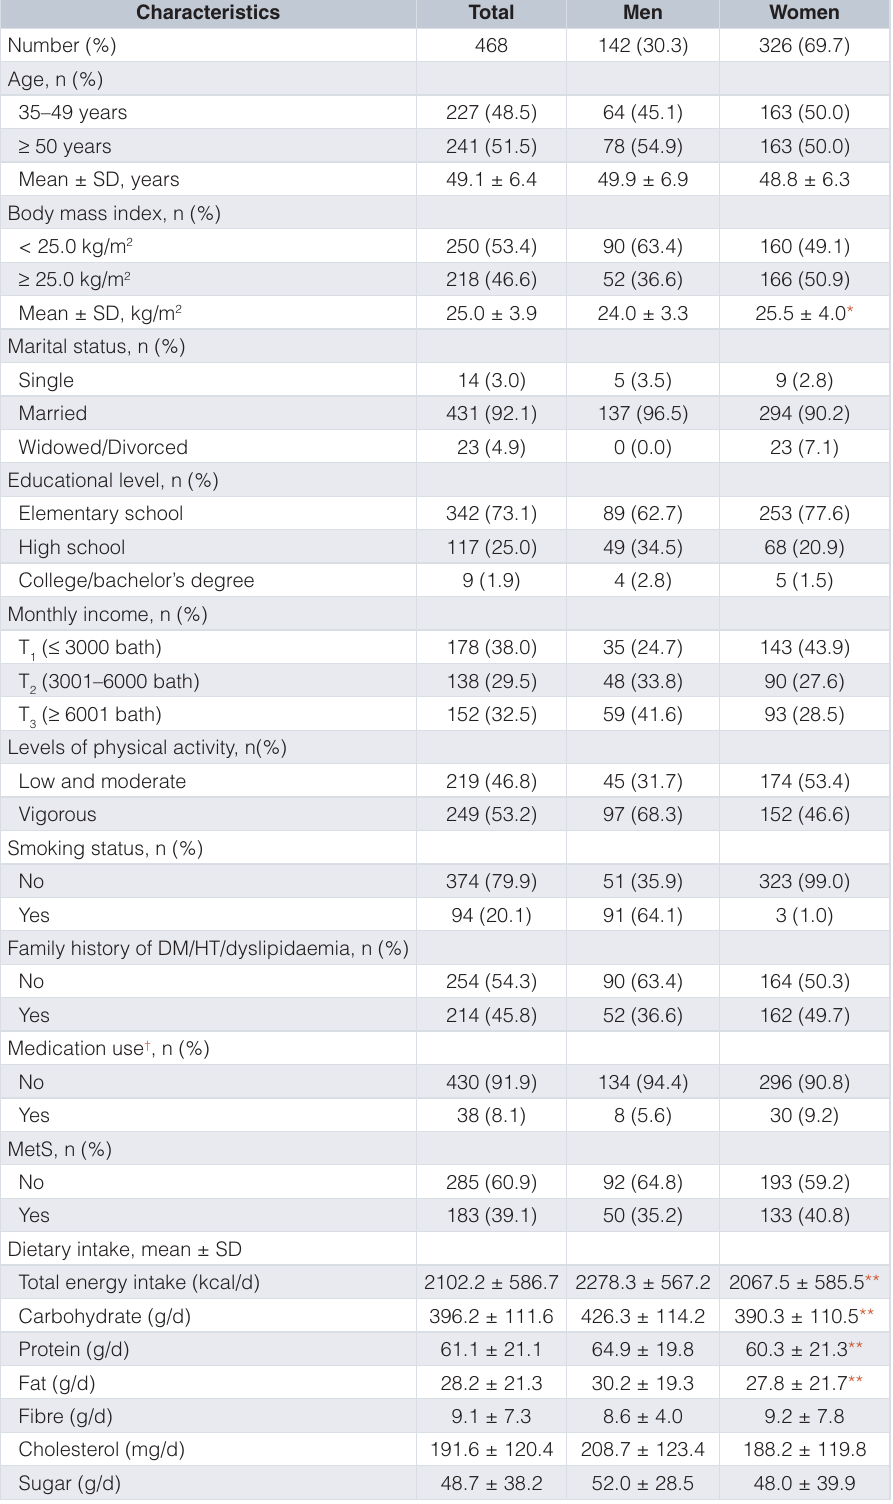
Table 1. Characteristics of the study